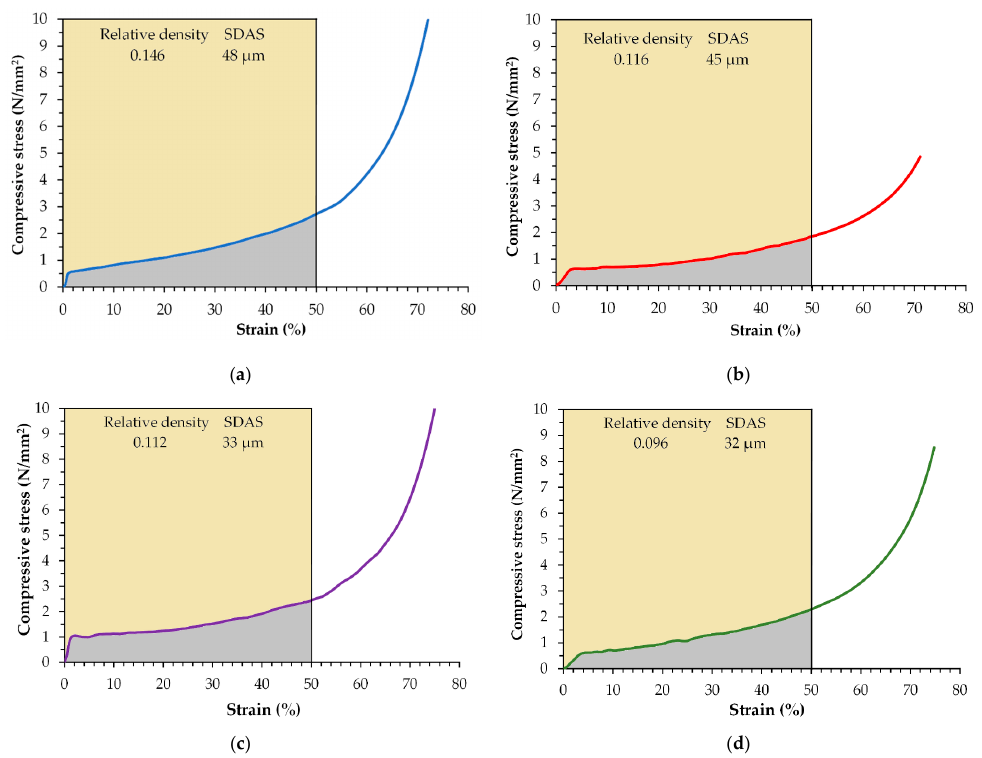
Figure 12. Compressive stress ‐ strain curves of A356 aluminum alloy foams of ( a ) Foam 1, ( b ) Foam 2, ( c ) Foam 3, and ( d ) Foam 4. The experimental mechanical properties obtained from the compressive stress ‐ strain curves are summarized in Table 4.